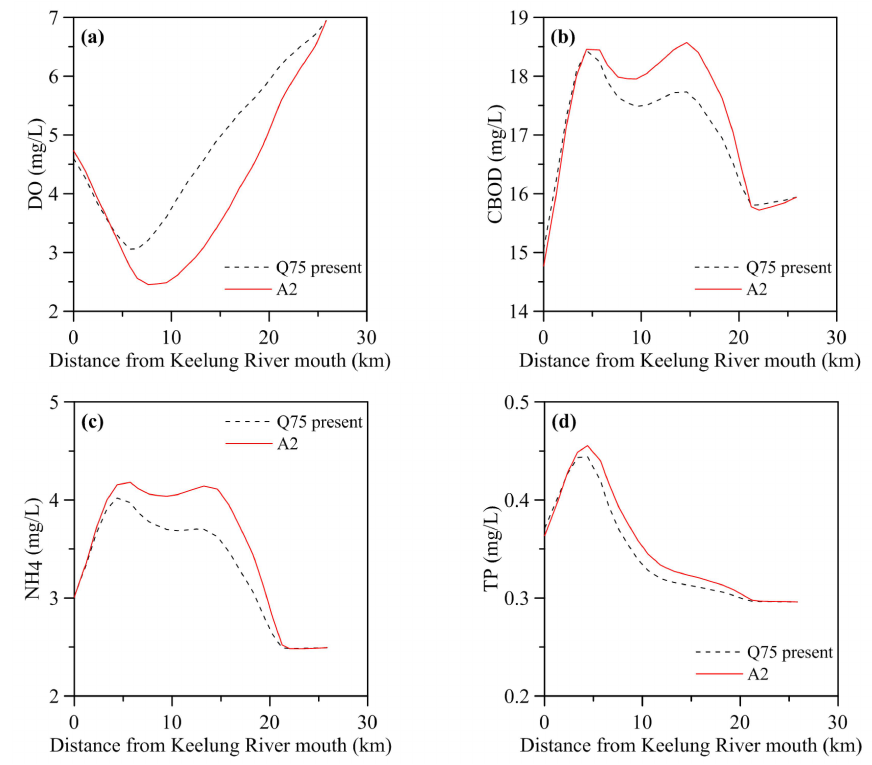
Figure 10. Predicting water quality distribution for present and climate change (A2 scenario) conditions under Q75 low flow along the Keelung River ( a ) DO; ( b ) CBOD; ( c ) NH4; and ( d )